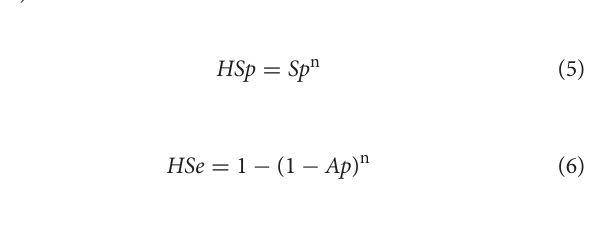
No. of herds sampled